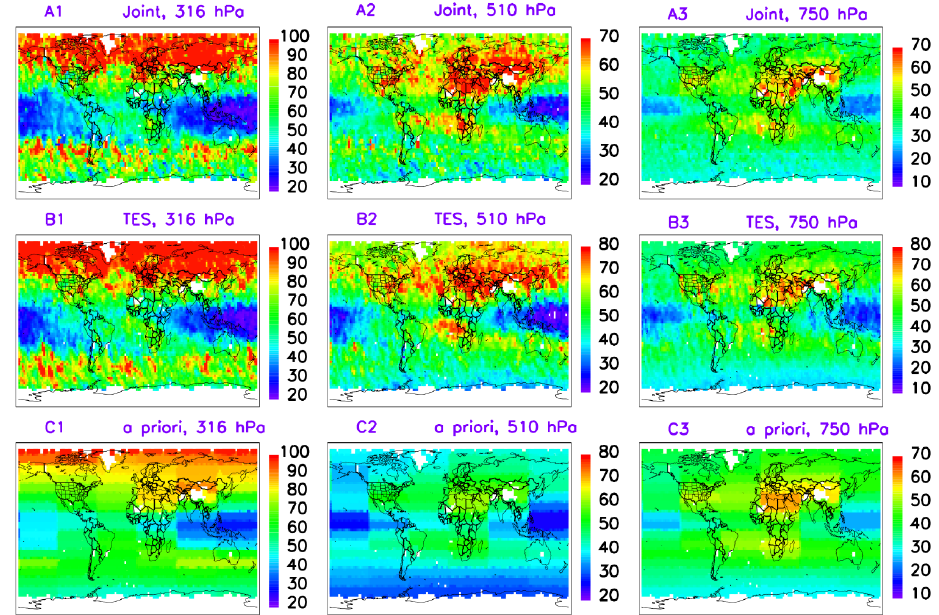
Figure 3. Global maps of monthly averaged ozone (O 3 ) volume mixing ratio (VMR) in units of ppb. The A-Train measurements in August 2006 were used in creating these global maps. Comparison of joint AIRS + OMI (A) , TES (B) , and a priori (C) ozone VMR for the pressure level of 316, 510, and 750hPa (columns left, middle, right), respectively. All data have been gridded to 2 . 5 ◦ × 2 . 5 ◦ cells. Results for the remaining months of 2006 are available in Figs. S1–S11 in the Supplement.